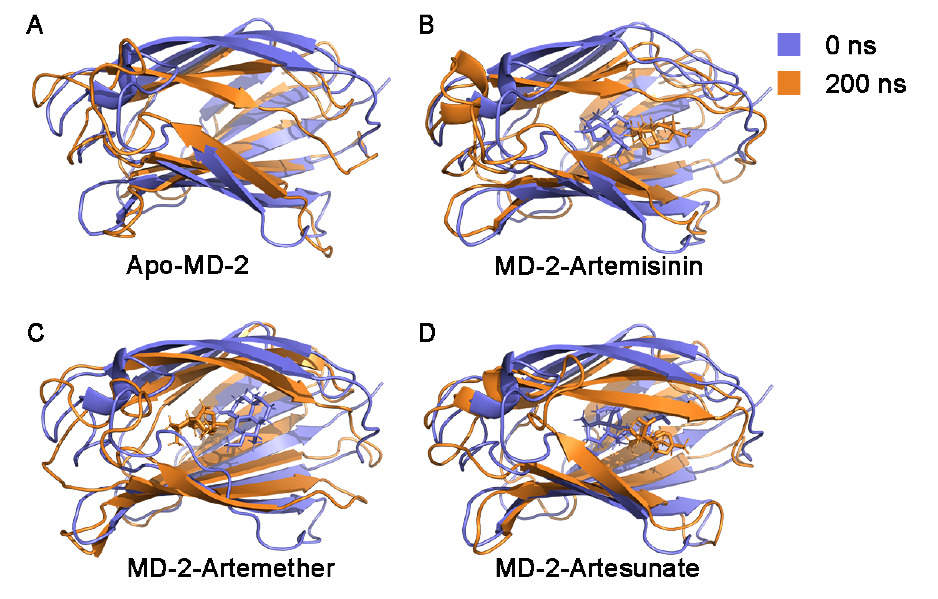
Figure 6. Structural superimposition of initial (0ns) and final configurations (200ns) of ( A ) Apo- MD-2, ( B ) MD-2-Arteminsinin complex, ( C ) MD-2-Artemether complex, and ( D ) MD-2-Artesunate complex. Initial conformations are colored in blue. Final conformations are colored in